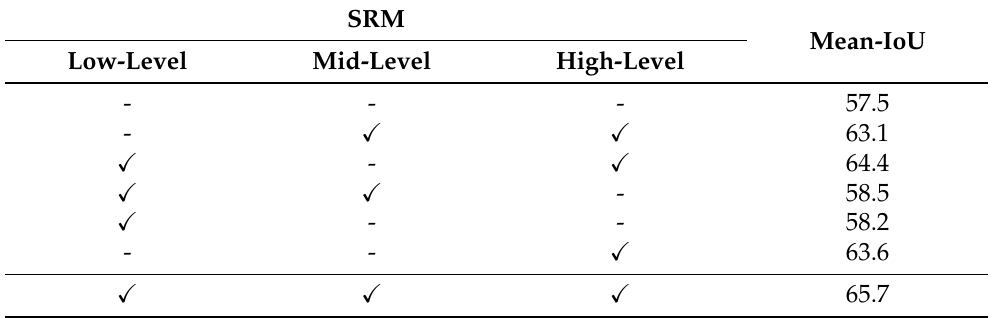
Table 3. Comparison of the results of ablation experiments at different numbers of SRMs on PASCAL-5 i .